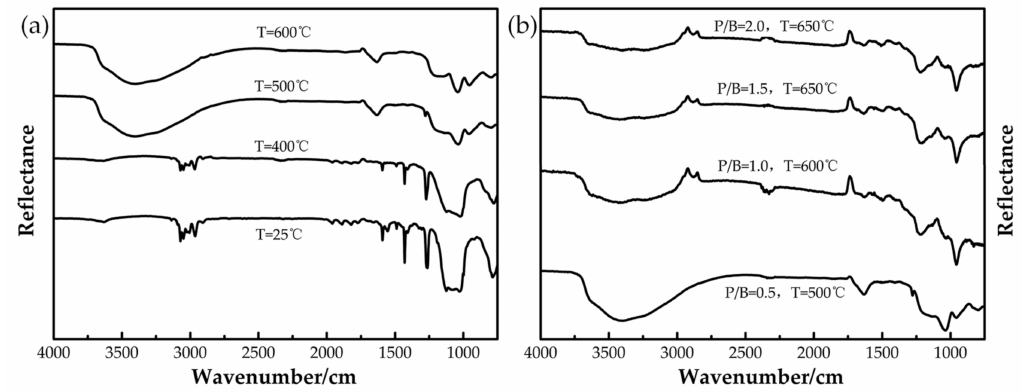
Figure 3. FTIR reflectance spectra of polysiloxane/Al coating with ( a ) P/B = 0.5 after heat treatment; ( b ) different P/B ratios after heat